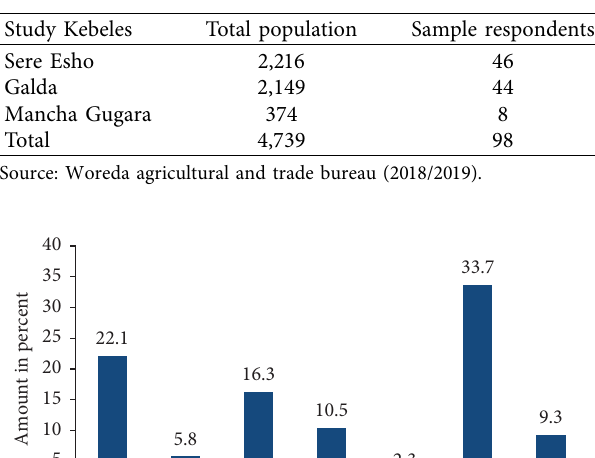
Table 1: Determination of sample households’ size of the study Kebeles.